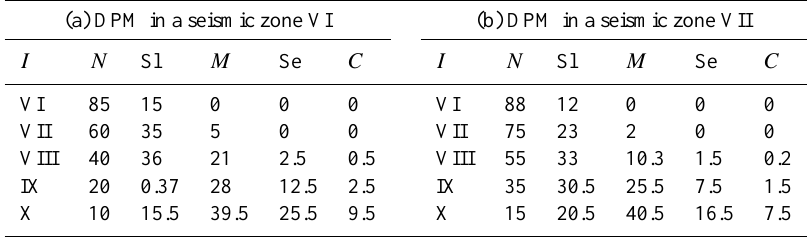
Table 1. DPM of B1-type buildings in a seismic zone VI and VII (%) (adapted from Yin, 1995).